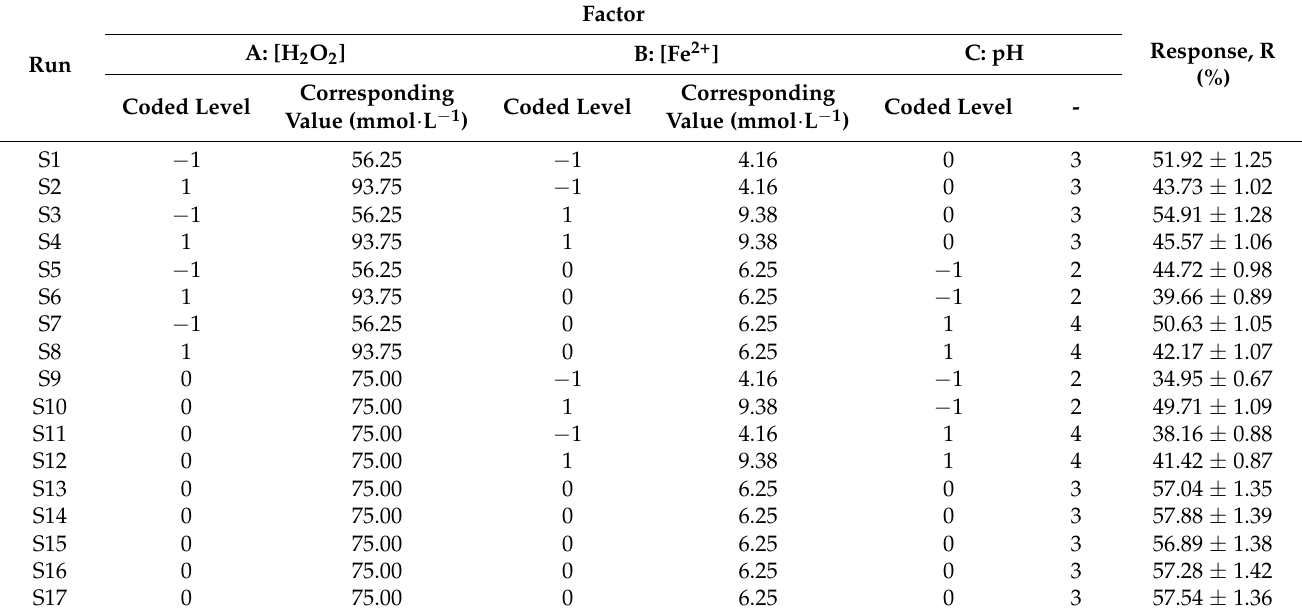
Table 2. Coded levels and corresponding values for test factors in RSM experimental